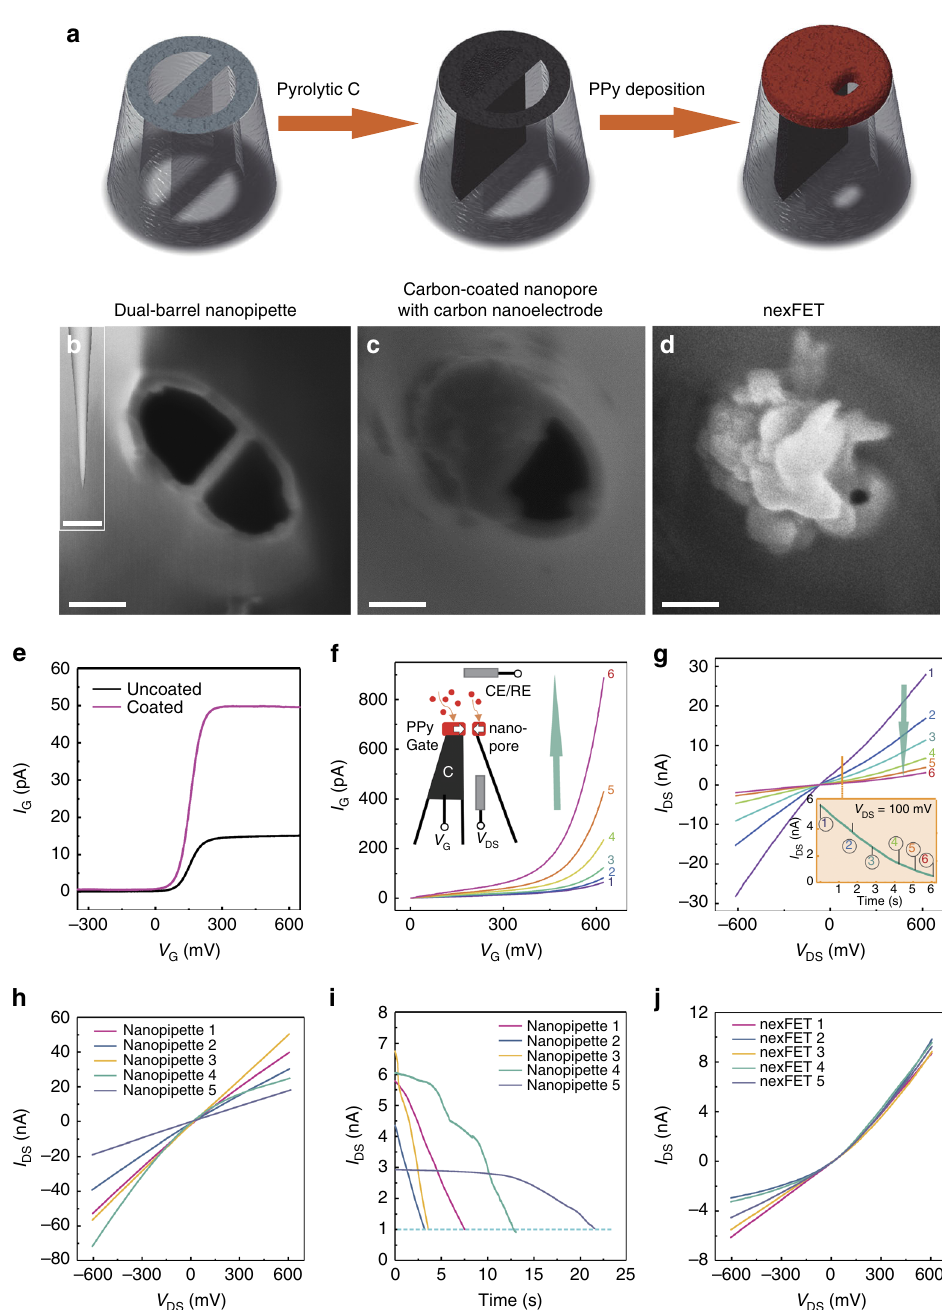
Fig. 2 Fabrication and characterization of the nexFET. a The nexFET is fabricated in dual-barrel quartz nanopipettes by a pyrolytic carbon deposition in one of the barrels, followed by electrodepositing of PPy at the carbon-coated nanopipette tip. SEM images at each stage of the fabrication process are shown in b quartz double barrels after nanopipette pulling (scale bar 100 nm, inset 20 μ m). c One barrel coated with carbon after pyrolytic deposition ( scale